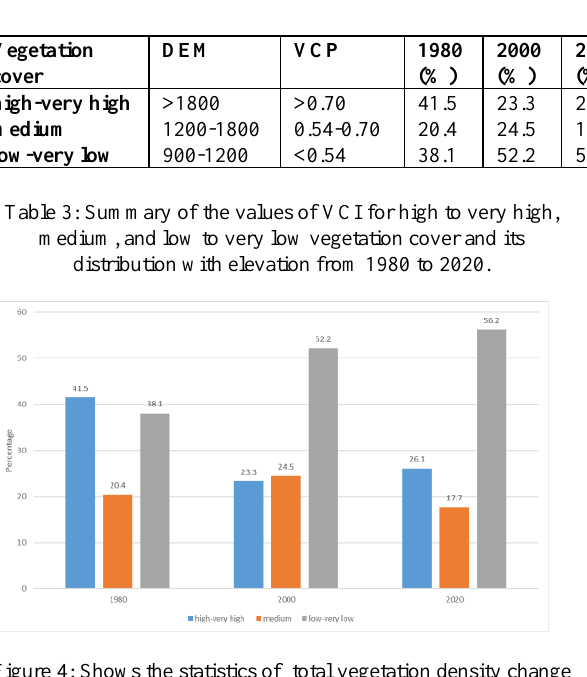
Figure 4: Shows the statistics of total vegetation density change from very high to very lower in the 1980s, the 2000s, and 2020 The result in Fig. 4.1 and Table4.1 that very high vegetation density occupied the largest percentage of the area having an altitude greater than 1800m, with a very high vegetation density of approximately 41.5%, 23. %, and 26.6 % of the total area from 1980, 2000, and 2020 respectively. Medium vegetation density located mostly from 1200m -1800m altitude in a large portion of the approximately 20.46%, 24.5%and 17.57% from 1980 and 2020. While most of the low to very low vegetation density comprises a height of less than 1200m. low to very low vegetation density was estimated at 38.1% and 56.2%, respectively, in 1980 and 2020. The result (Table 4.1) revealed that the very high vegetation density cover was reduced by up to 15% throughout the study period in the past four decades. While the increase in very low to low vegetation density from the 1980s to 2020 was found of 19% of the increase in the total area.